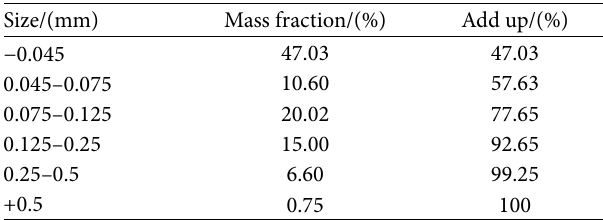
Table 1: Particle size classification of fly ash from Dananhu no.1 coal